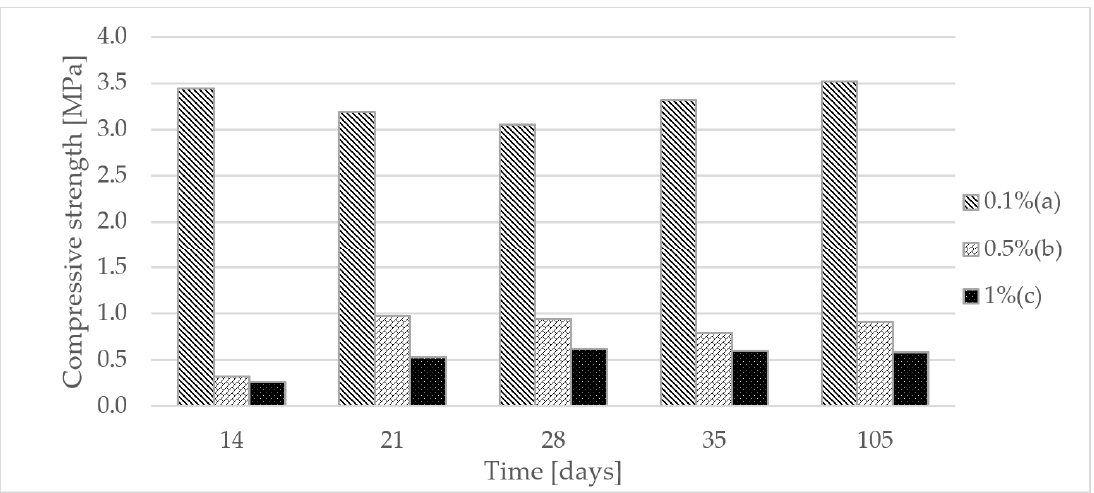
Figure 2. Compressive strength of gypsum samples depending on the polymer content (a) 0.1%; (b) 0.5%; (c) 1%.